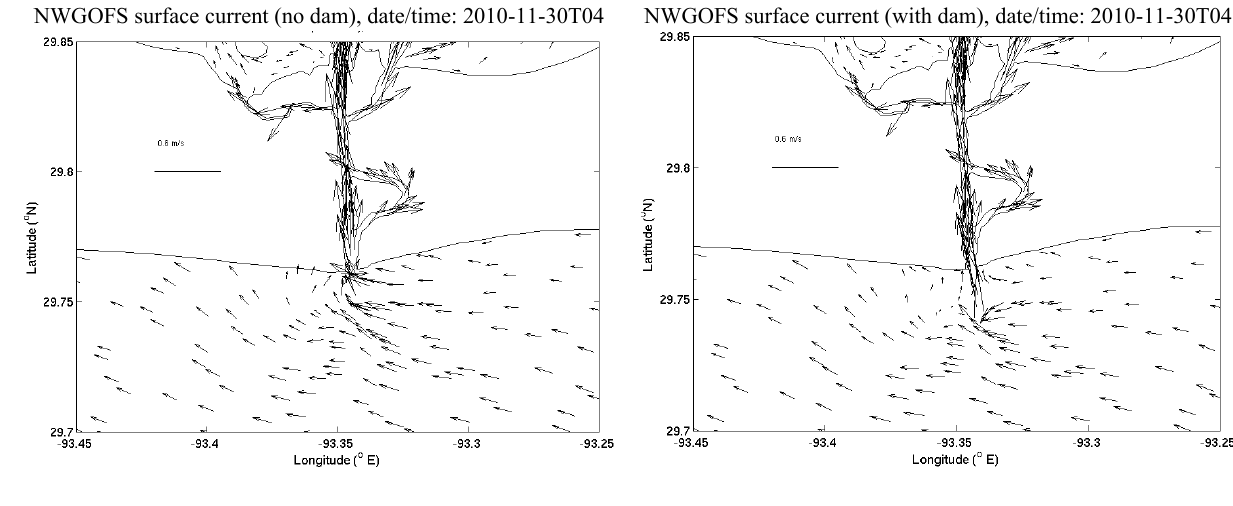
Figure 6. Velocity vectors at Lake Calcasieu entrance without (left) and with (right) jetties. NWGOFS surface current (no dam), date/time: 2010-11-30T04 NWGOFS surface current (with dam), date/time: